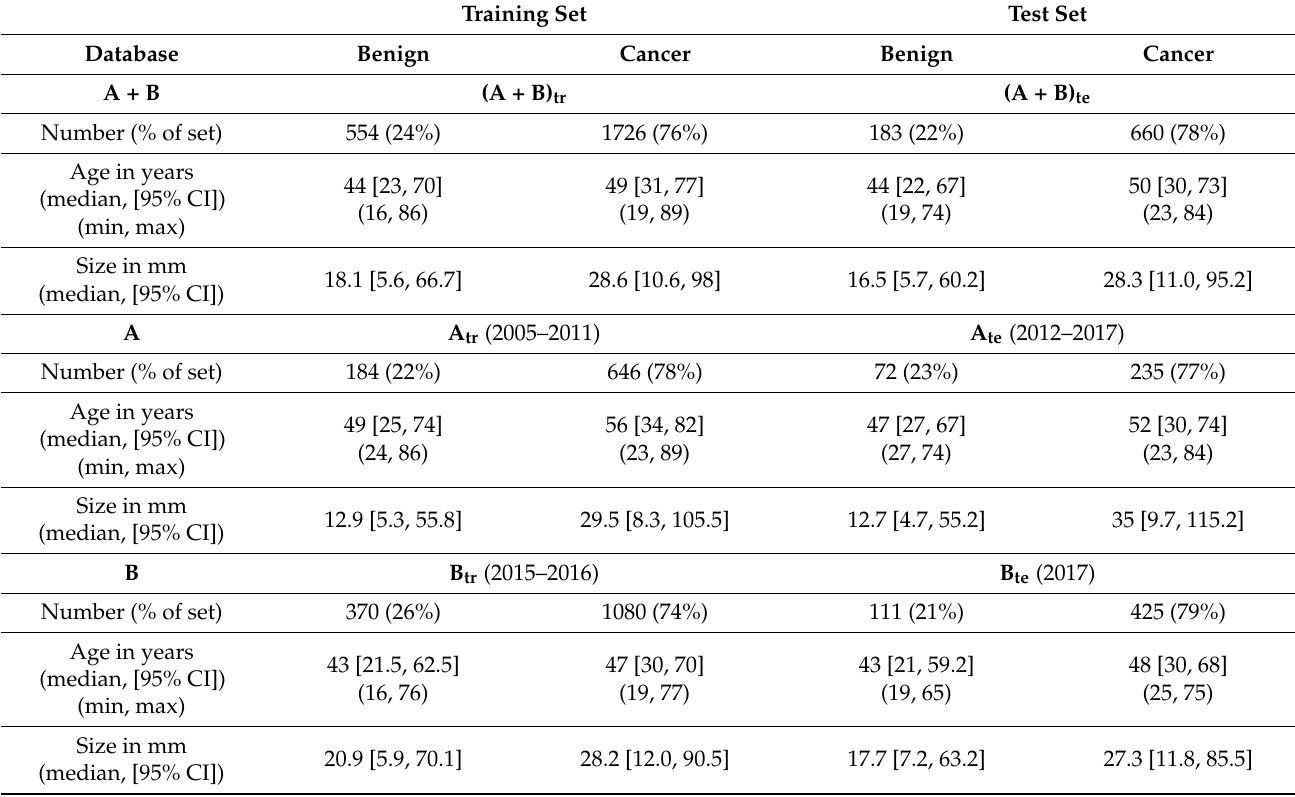
Table 1. Description of the dataset: number of lesions, age of subjects, and size of lesions, by database. The size of lesions is given as maximum linear size (extracted radiomic feature S4, see Table 2 below) (A: Database A; B: Database B; CI: confidence interval; min: minimum; max: maximum; tr: training; te: